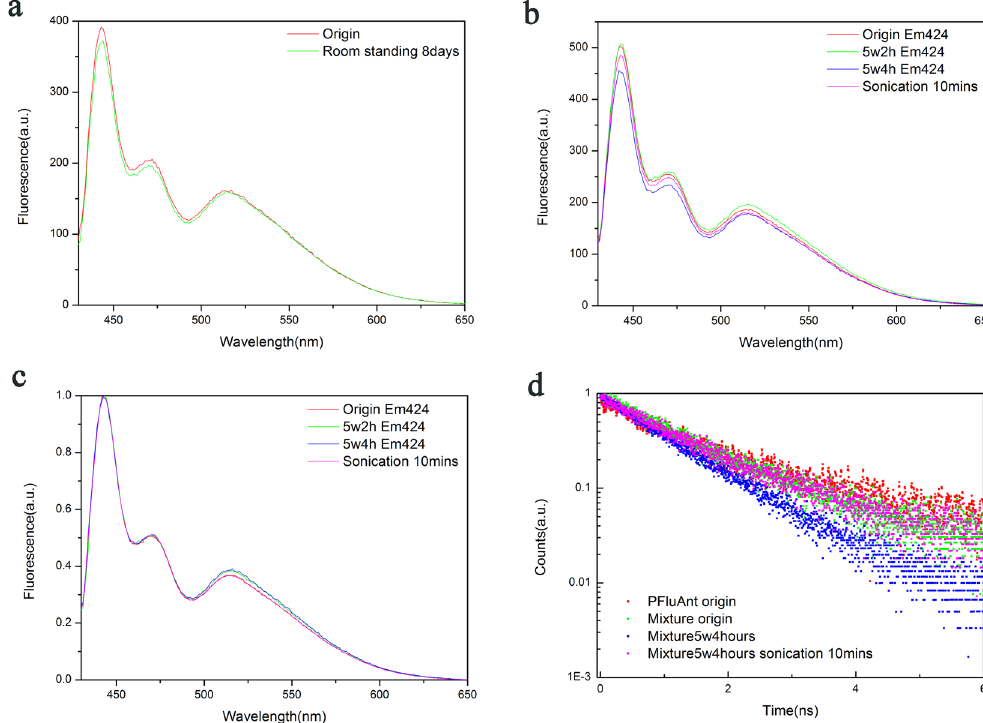
Figure 3. Steady state and time-resolved fluorescence spectra of PFluAnt solution or PFluAnt&PFOBT mixture. ( a ) Fluorescence spectra of PFluAnt&PFOBT mixture in PFluAnt solution after 8 days’ standing under room illumination. ( b ) Fluorescence spectra of PFluAnt&PFOBT mixture after irradiance with 5 W desk lamp. ( c ) normalized spectra of PFluAnt&PFOBT mixture after irradiance with 5 W desk lamp. ( d ) Time resolved fluorescence spectra of PFluAnt solution and PFluAnt&PFOBT